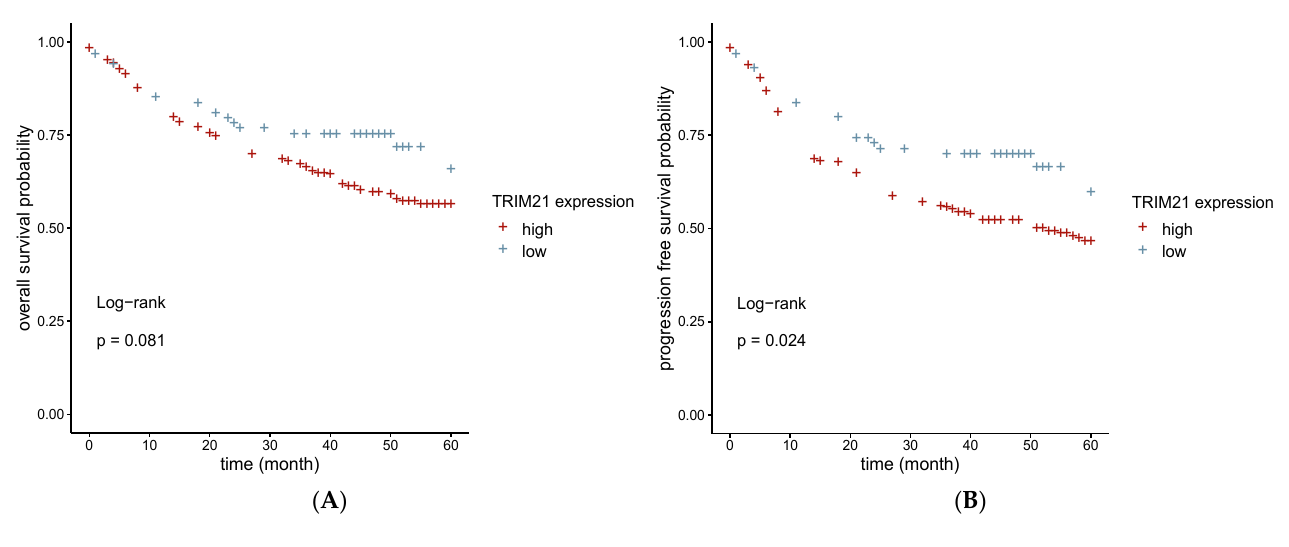
Figure 6. Kaplan–Meier analyses of TRIM21 expression in PTs. ( A ) We did not observe a significant difference in OS over 60 months in patients with high TRIM21 expression compared with patients with low TRIM21 expression (log ‐ rank test, p = 0.081). ( B ) We observed a significantly shorter 5 ‐ year PFS rate in patients with high TRIM21 expression compared with patients with low TRIM21 expression (log-rank test, p = 0.024). Table 1. Cox regression analysis of TRIM21 expression (* p < 0.05).